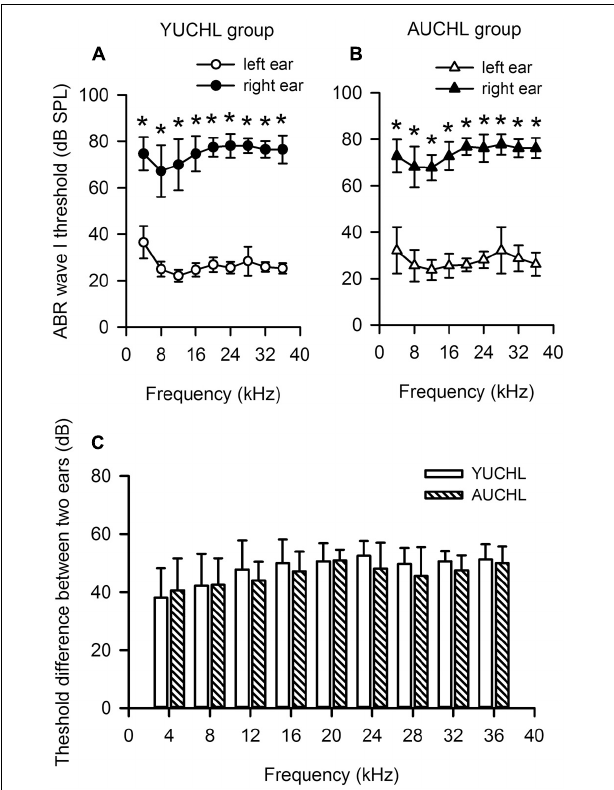
FIGURE 1 | Unilateral conductive hearing loss (UCHL) elevated the auditory brainstem response (ABR) wave I threshold in the operated left ear. YUCHL group: young unilateral conductive hearing loss group; AUCHL group: adult unilateral conductive hearing loss group. Data (shown in mean and standard deviations) were from a subset of rats in the YUCHL group ( n = 15) and the AUCHL group ( n = 15). (A,B) The ABR wave I thresholds determined independently from the intact left ear and right ear with UCHL in both the YUCHL group (A) and the AUCHL group (B) . ∗ indicates significantly different in ABR wave I threshold compared to the corresponding data from the left ear (Wilcoxon Signed Rank Test, p < 0.001). Note that the ABR thresholds determined in the right ear with UCHL were higher than those in the intact left ear. (C) The average differences in ABR wave I thresholds (right ear threshold minus left ear threshold) determined at each frequency. At each frequency, the threshold differences were not significantly different between the two groups (Mann–Whitney test, all p > 0.05). See texts in the “Materials and Methods” section for